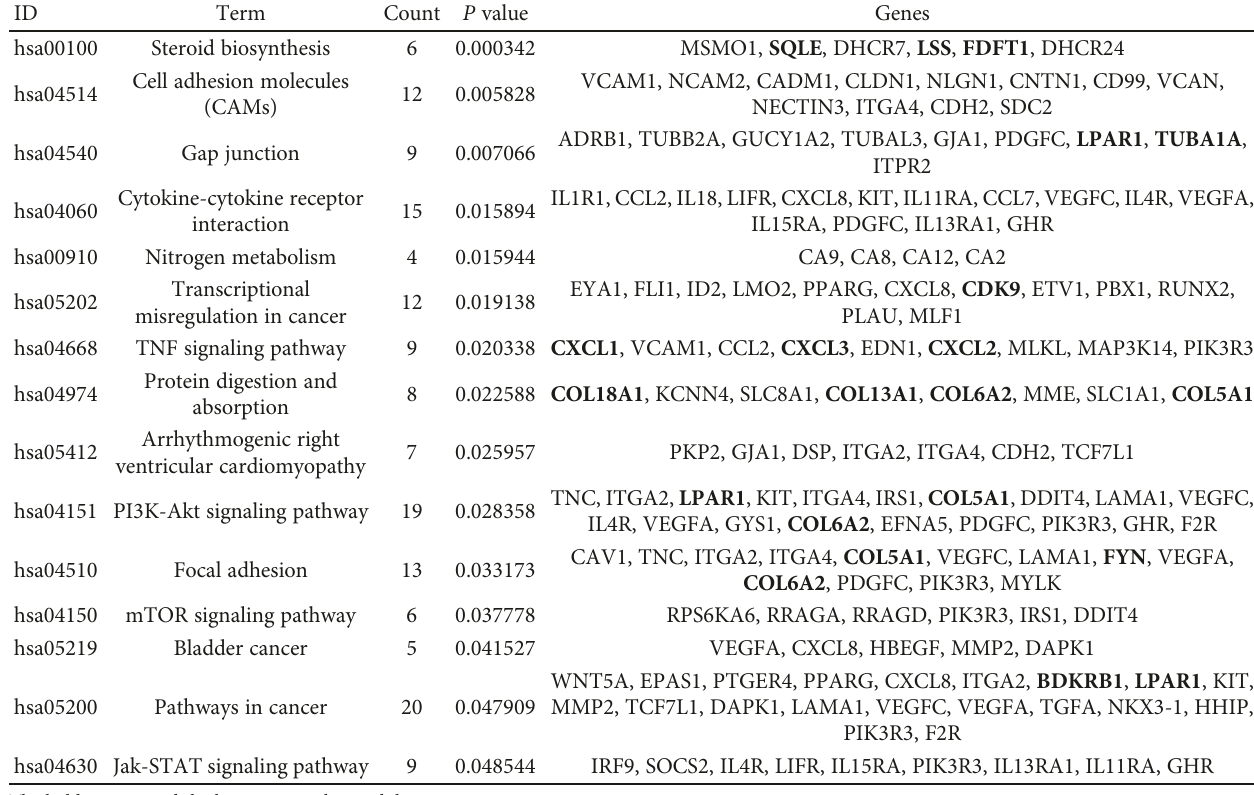
Table 4: Top fi fteen signi fi cant signaling pathways associated with DEGs in BC according to P